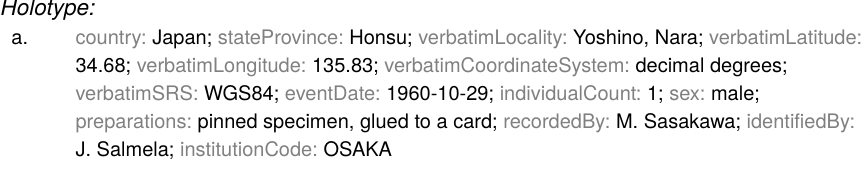
Male. Head black, vertex covered by pale setae, frons glabrous and face with scattered apical setae; face basally, close to scape, yellowish. Ocelli in a shallow triangle, median ocellus smallest. Clypeus with microtrichosity (pruinosity), elongated (about 1.7 times longer than basally wide). Scape yellowish and brownish, pedicel yellow and fi rst fl agellomere basally yellowish. Length ratio of pedicel: fi rst fl agellomere 0.24. Flagellomeres dark, palpus yellow. Thorax dark-brown with pale setosity. Scutum shining, pleural sclerites with weak microtrichosity. Antepronotum yellow. Halter yellow. Femora yellow, bearing pale setae. Trochanters infuscated. Femora yellow, but mid and hind femora ventrobasally infuscated. Legs gradually darkening toward tarsi. Tibial spurs brownish. Length ratio of femur to tibia for fore, mid and hind legs: 0.77, 0.66, 0.66. Length ratio of tibia to basitarsus for fore, mid and hind legs: 1.06, 1.68, 1.68. Apex of wing slightly infuscated. Bases of M1 and M2, M1+2, r-m, bM1+2, Rs, A1 and Sc bare, other veins setose. C exceeding tip of R5 36 % of the distance between R5 and M1. Sc ending in C at the level of Rs. Length ratio of M1+2:r-m = 1.19. Cu forking slightly beyond M end of r-m. Wing length 5.0